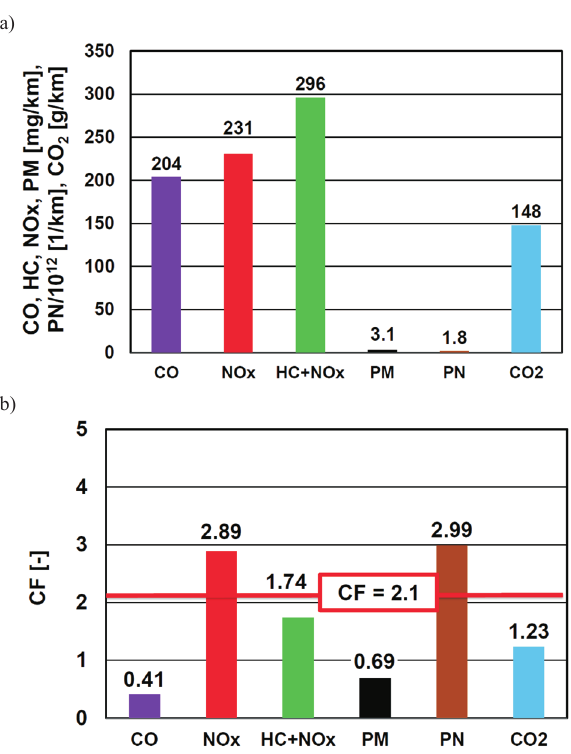
Fig. 8. Road emission values (a) and their respective conformity factors (b) determined during road tests for a vehicle equipped with a diesel engine (all results)